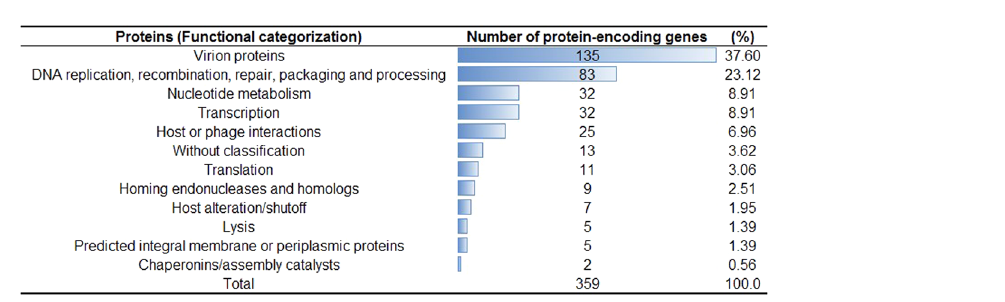
Figure 2. Variants calling between vB_EcoM-UFV13 and Enterobacteria phage T4 were predicted using SnpEff. Only variants with predicted “high” or “moderate” impact on the protein-coding gene were analyzed and functionally